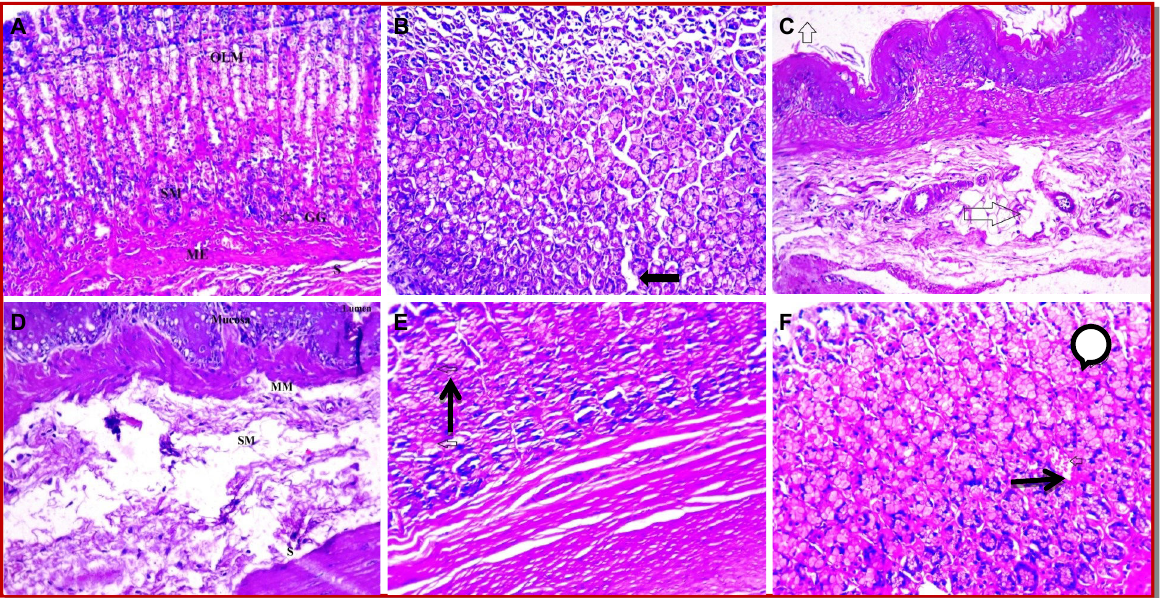
Figure 1: Histological examination of gastric ulcers; A : Photomicrograph of rat stomach section from the control group showing the histological structure of the normal submucosa (SM), gastric gland (GG), serosa (S), muscularis externa (ME), outer longitudi- nal muscle (OLM); B : Standard group (omeprazole) is showing normal appearance of Gland cell and sub mucosal cell; C : Disease control (Ethanol induce ulcer) is indicating mucosal and sub mucosal ulceration along with loss epithelium cells in gastric mucosa; D : Disease control group (Indomethacin) is showing stomach of the ulcer control animal showing a severe effect on the sub- mucosa with erosion, edema, moderate leucocyte infiltration and cellular debris; E : Methanolic extract 750 mg/kg + ethanol treat- ed group is showing normal muscularis mucosa (MM), Submucosa (SM) and blood in mucosa cells; F : n -hexane 750 mg + ethanol treated group is indicating condensation of mucosa and clustering of RBC’s in sub mucosal